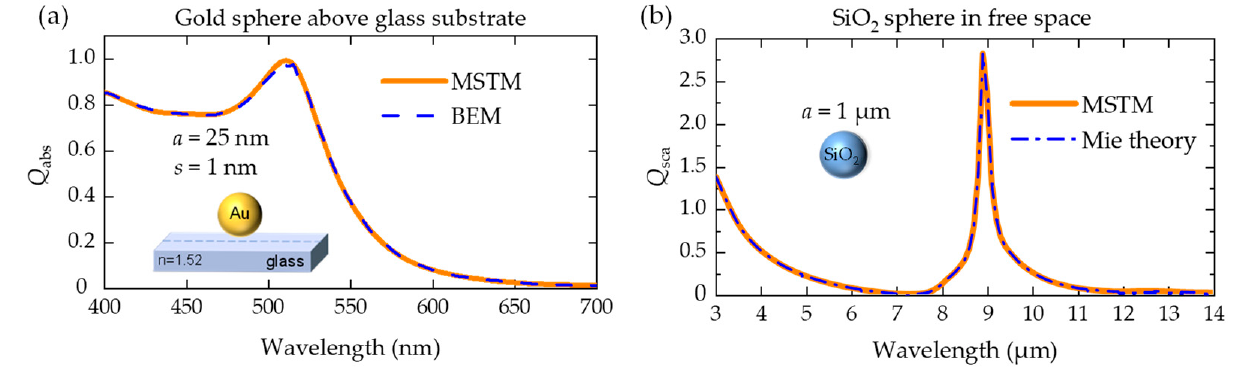
Figure 2. ( a ) The absorption cross sections of a gold sphere above the glass substrate calculated by MSTM and BEM [36]. ( b ) The infrared sca tt ering e ffi ciencies of a SiO 2 sphere in a vacuum are calcu- lated by the MSTM method and Mie theory.